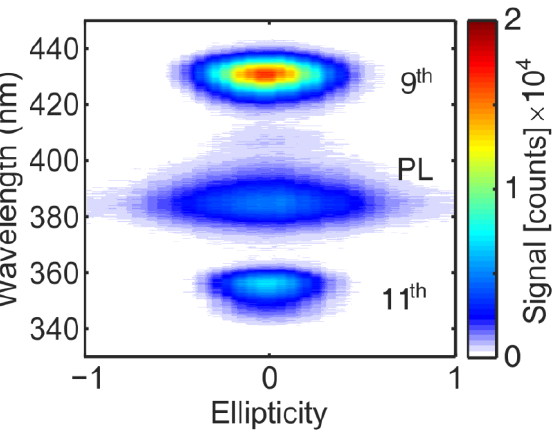
Figure 2. Photoluminescence (PL) and high harmonic emission from a ZnO thin film irradiated with femtosecond laser pulses at 3.8 µm as a function of the laser ellipticity.